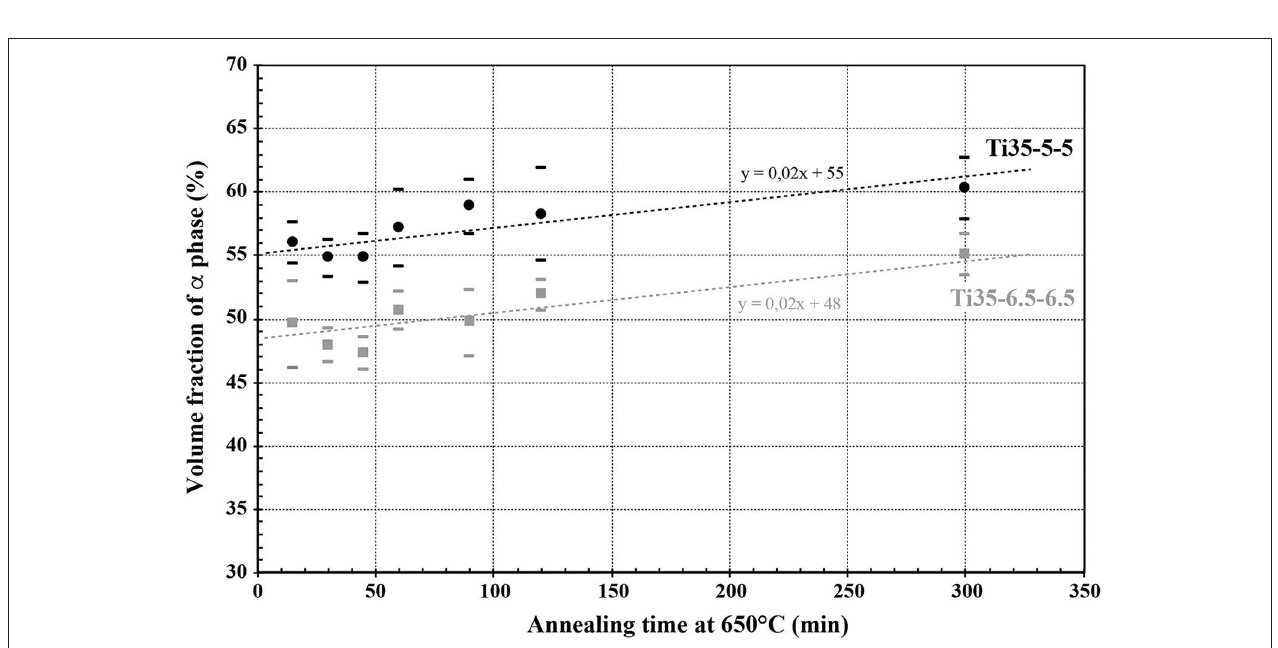
FIGURE 3 | Volume fraction of α phase for different annealing times at 650 ◦ C for both alloys.